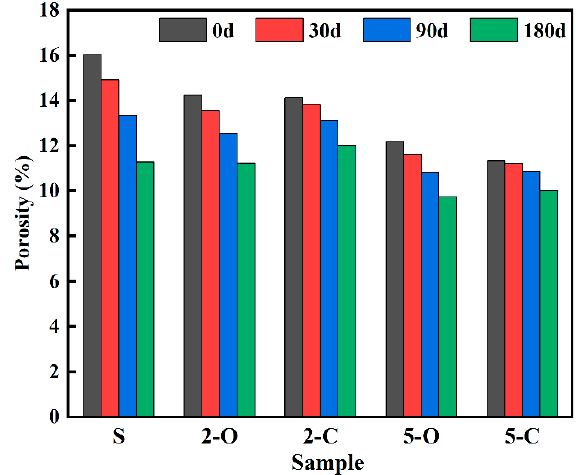
Figure 6. Porosity of samples under sulfate attack.